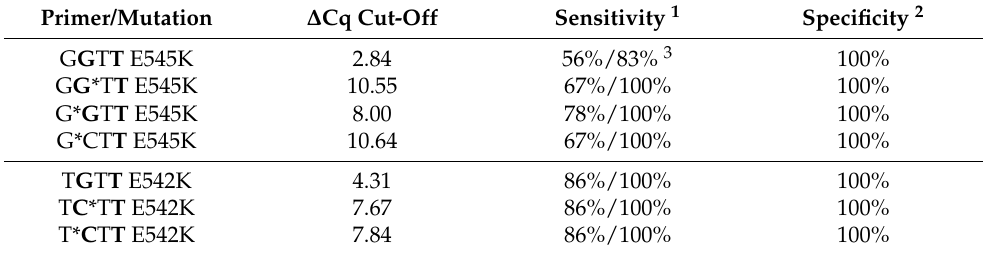
Table 5. Validation of AS primers on DNA samples from